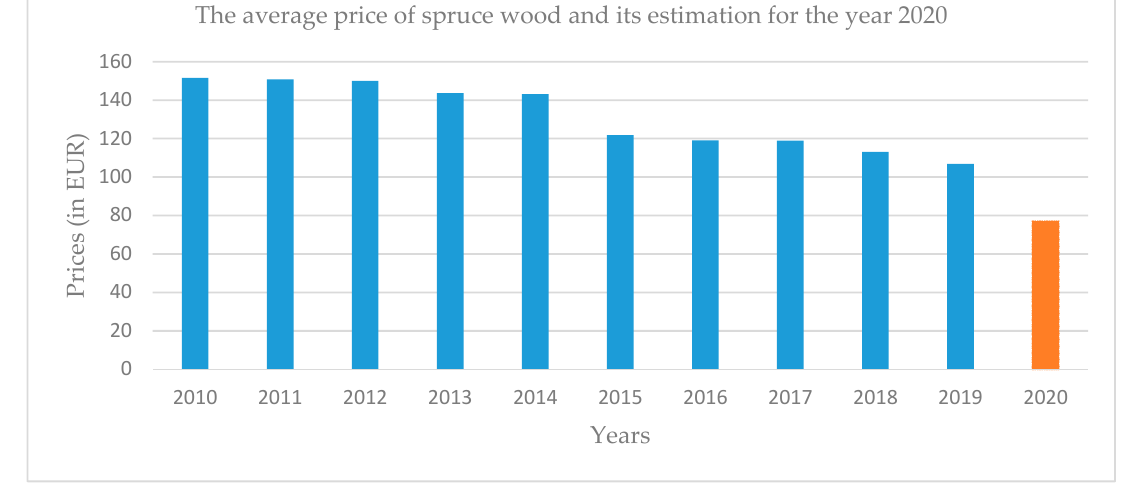
Figure 2. The average price of spure and fir sortiment in the quality SM/JE II and the estimated price for the year 2020. Source: own calculations.